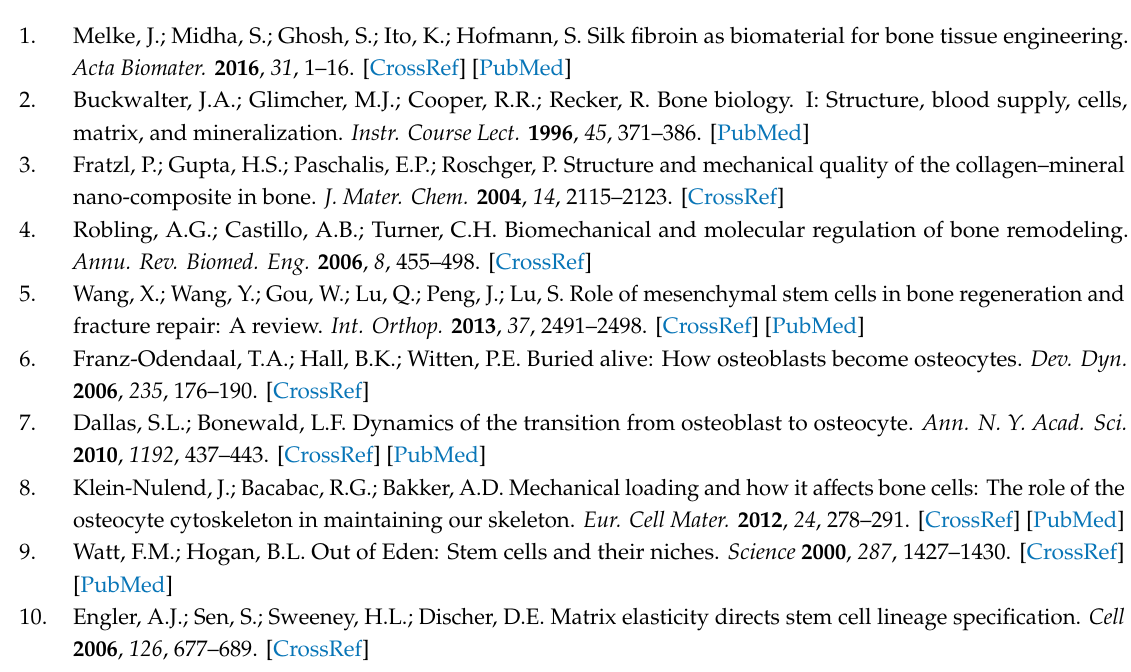
Supplementary Materials: The following are available online, Figure S1: Representative stress-strain curves of all samples and control, Figure S2: Representative diagrams of deconvoluted peaks in amide I band region, Figure S3: Cellulose framework and SF matrix, Figure S4: Di ff erent bulk and surface